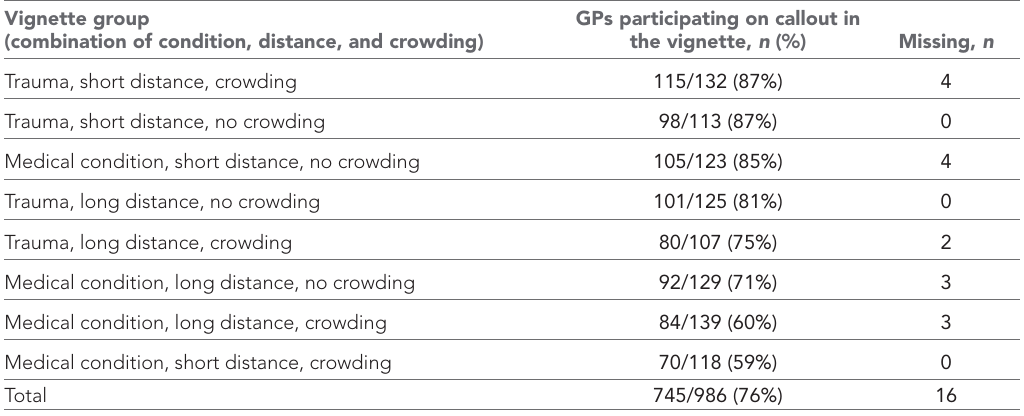
Table 3 Vignettes ranked in order of participation rates (from high to low) Vignette group (combination of condition, distance, and crowding)